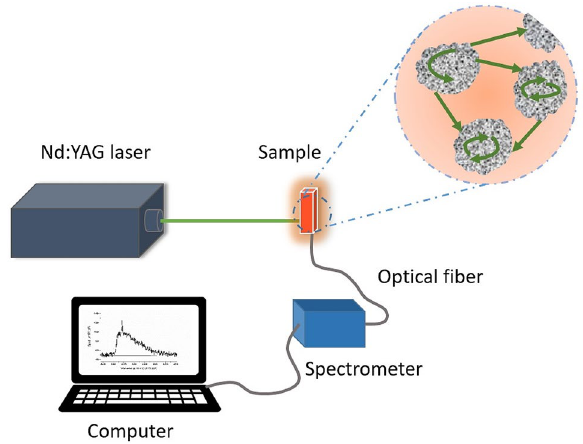
Figure 1. Schematic experimental setup of the random Raman laser